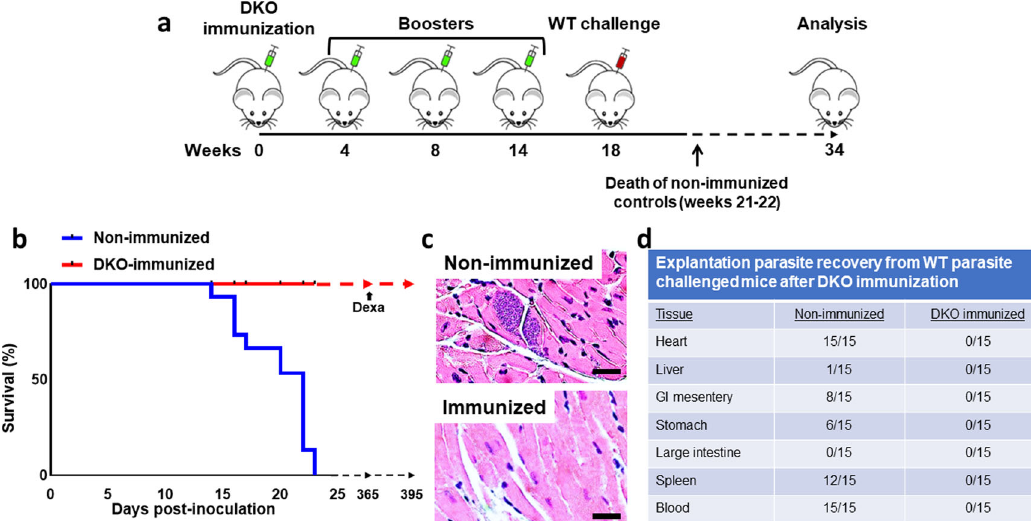
Fig. 8 Challenge of mice immunized with DKO parasites. a Timeline of immunization and infection of A/J mice. Mice were immunized with 10 5 cell-culture-derived metacyclic trypomastigotes and then given three booster doses at indicated times with the same amount of metacyclics followed by challenge with WT RHM-derived trypomastigotes 18 weeks after the fi rst dose of DKO parasites. Non-immunized mice served as controls. Terminal analyses of DKO-immunized mice were conducted 16 weeks after WT challenge. b Survival curve of WT- challenged non-immunized control mice and DKO-immunized mice. DKO-immunized mice survived WT challenge whereas all non- immunized mice died within 14 – 23 days post-challenge. In replicate experiments, WT-challenged DKO-immunized animals survived up to one-year post-challenge. Treatment of these animals with dexamethasone (Dexa) does not induce clinical disease, alter survival or cause the emergence of parasites from tissues of any animal (Supplementary Fig. 13). c Histopathologic analysis of heart sections of WT-challenged non- immunized (upper panel) and DKO-immunized mice (lower panel). d Explantation of indicated tissues in parasite culture medium from WT- challenged non-immunized or DKO-immunized mice 6 months (for DKO-immunized animals) post-infection. This is a compilation of data from 3 separate experiments with comparable results (5 mice per group in each experiment, n = 15). The Log-rank (Mantel-Cox test) was used for the Kaplan – Meier analysis. P < 0.05.